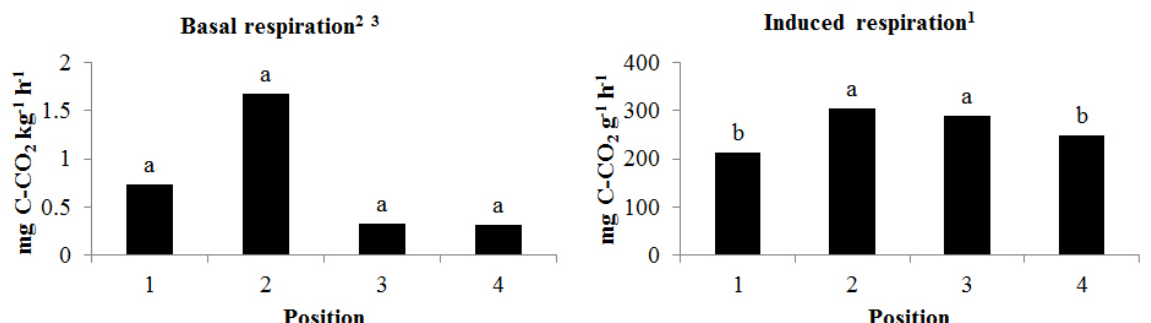
Figure 4 - Microbial respiration in soil samples (0 to 20 cm) in different hillslope positions in the Bocaina Mountain Range, in Lavras – Minas Gerais, Brazil. 1 - upper backslope; 2 - middle backslope; 3 - lower backslope; 4 - footslope. Means followed by the same letter do not differ from one another by the 1 Scott-Knott or 2 Kruskal-Wallis test (p <0.05); 3 transformed data per log (x).